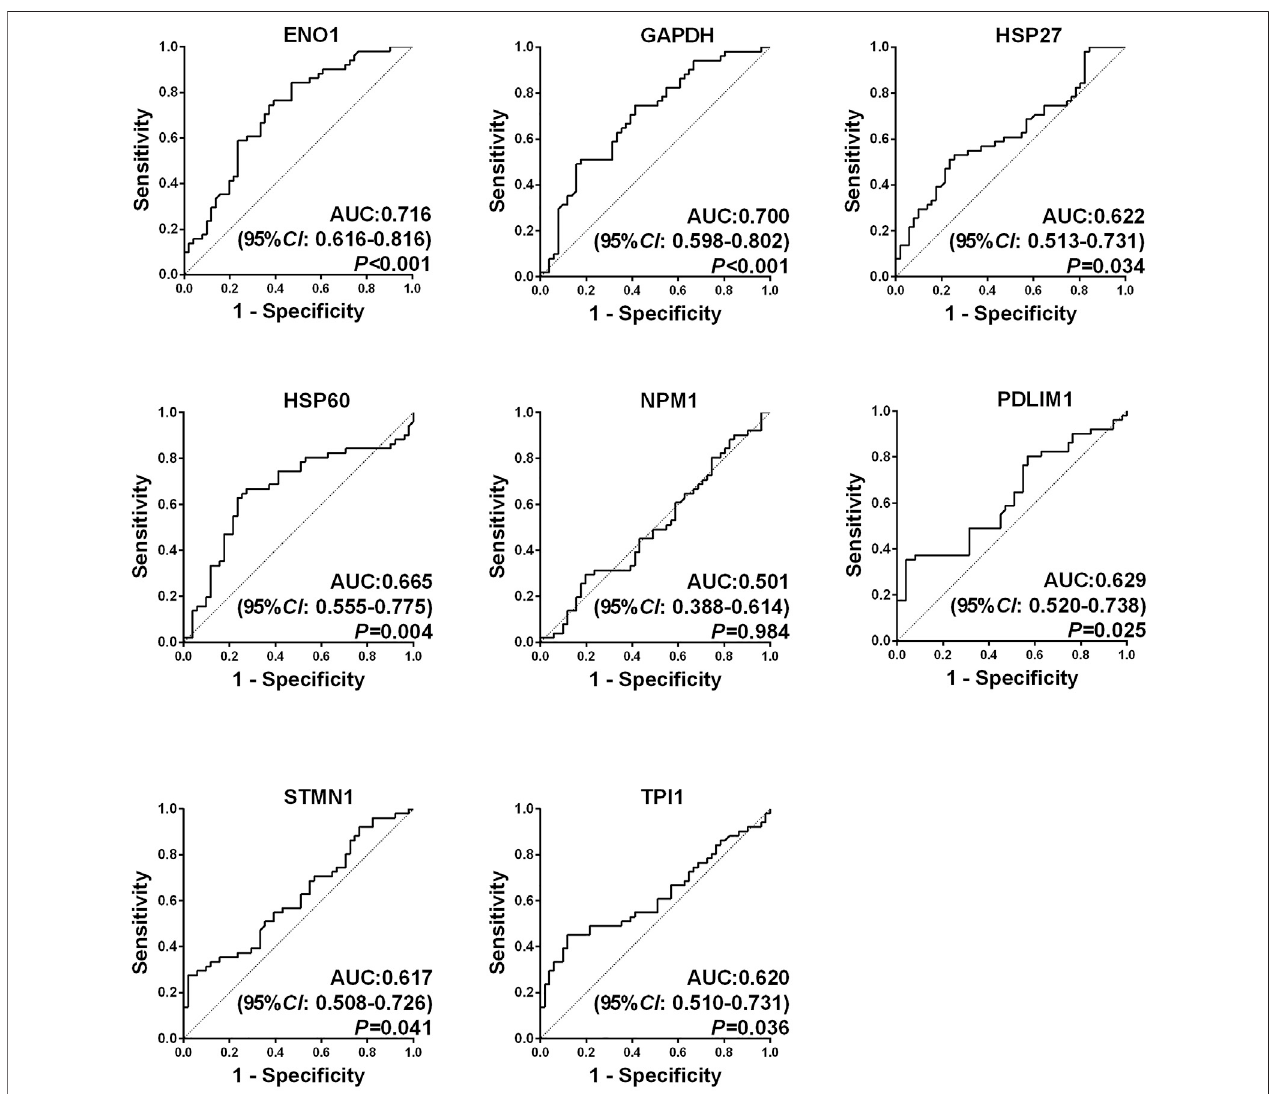
FIGURE 2 | Receiver operating characteristic (ROC) curves of eight candidate tumor-associated autoantibodies (TAAbs).